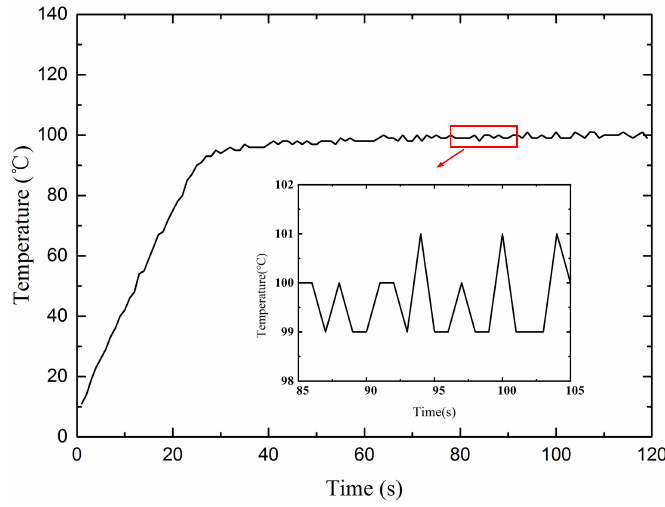
Figure 14. The temperature curve of the injection pipeline. The target temperature is 100 °C.